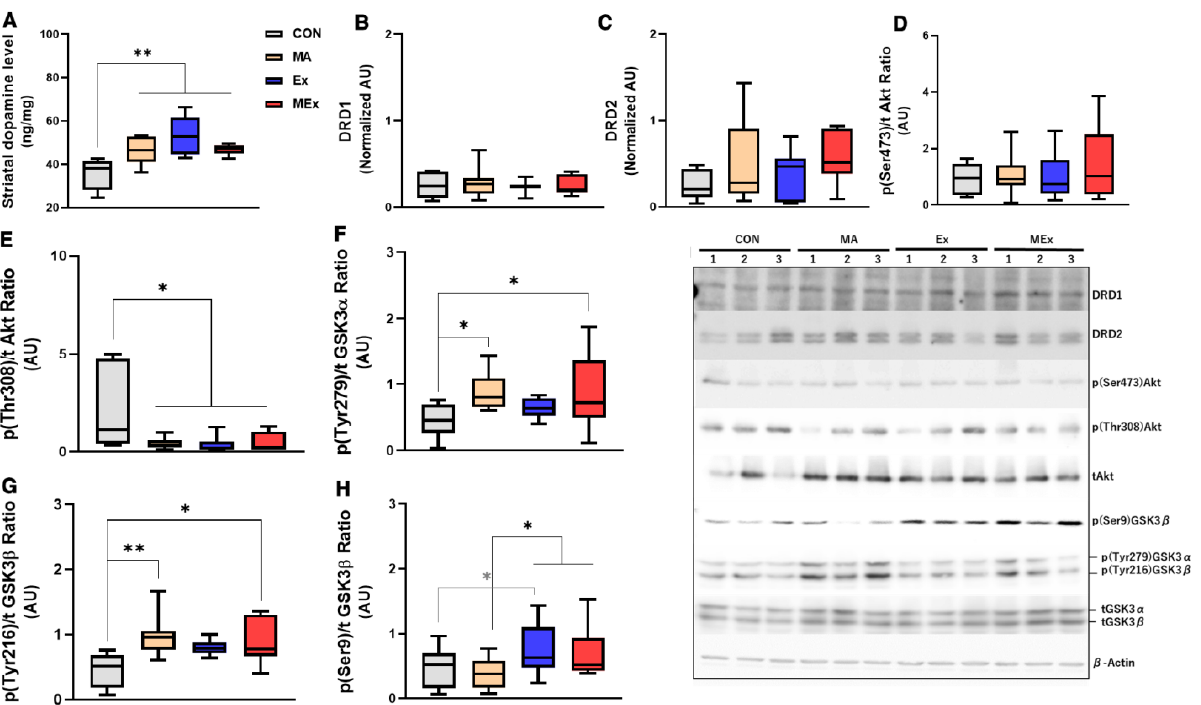
Figure 3. Forced moderate endurance exercise did not affect the methamphetamine (METH)-induced dopaminergic signaling pathway. Protein content was determined by Western blotting in the striatum of the brains of experimental rats. ( A ) Striatal dopamine level ( n = 8 per group, F (3, 28) = 10.25). ( B ) Dopamine receptor D1 (DRD1) expression level ( n = 8 per group, F (3, 28) = 0.2384). ( C ) Dopamine receptor D2 (DRD2) expression level ( n = 8 per group, F (3, 28) = 1.347). ( D ) p(Ser743)/t-Akt ratio ( n = 8 per group, F (3, 28) = 0.4629). ( E ) p(Thr308)/t-Akt ratio ( n = 8 per group, F (3, 28) = 6.311). ( F ) p(Tyr279)/t-GSK-3 α